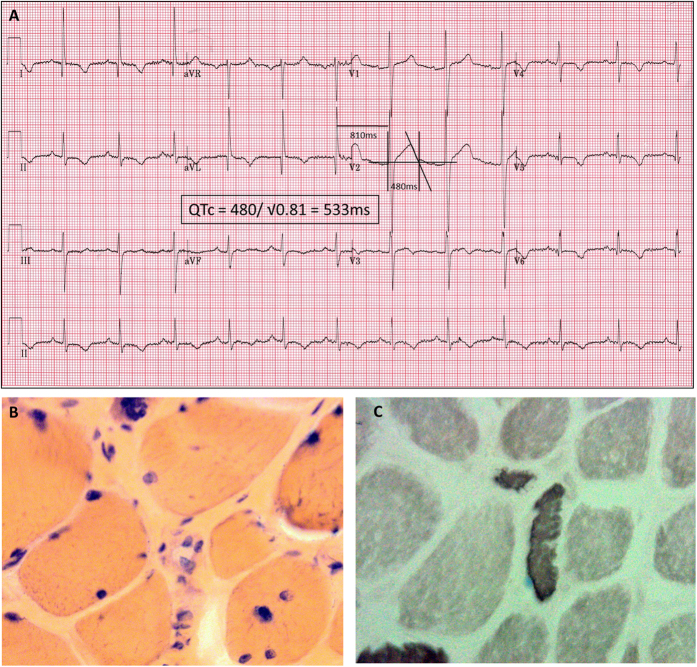
ECG and muscle biopsy.(A) Routine ECG on Patient III:1 three years after his presentation with an out-of-hospital cardiac arrest. Left ventricular hypertrophy by voltage criteria with lateral T wave changes are noted, as well as broad-based QT prolongation with a QTc of 533ms (using Bazett’s formula for correction). (B) Haematoxylin and eosin (x 40) staining of muscle biopsy from patient III:2 showed variation in fibre size with atrophic fibres. (C) Muscle biopsy from patient III:2 showed random atrophic fibers with scattered perivascular lymphocytes. Immunohistochemistry showed that the atrophic fibers were type II with type I fiber predominance.